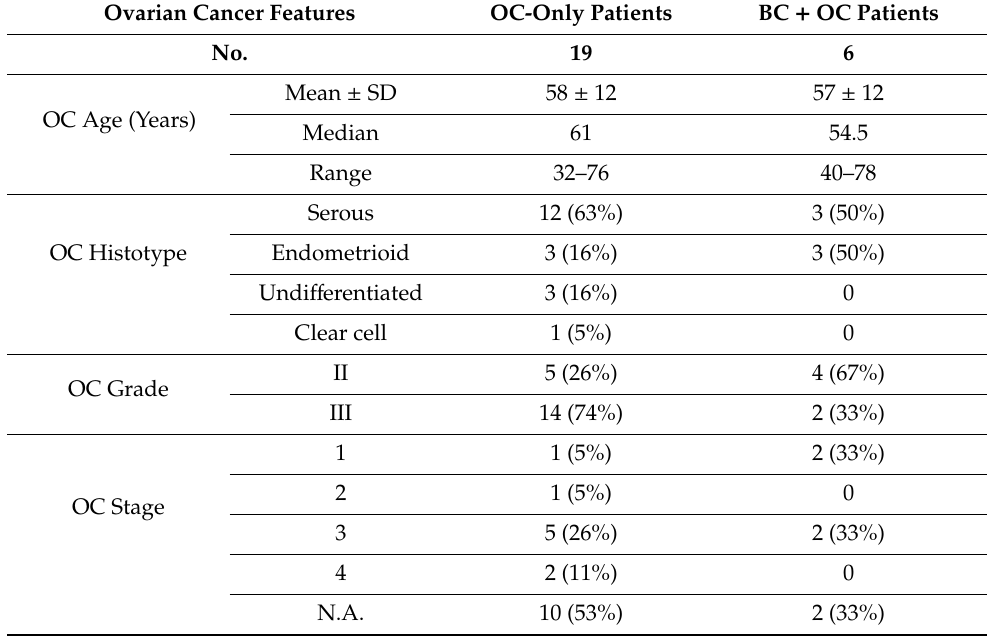
Table 3. Main features of ovarian cancer cases in the study cohort. BC, breast cancer; OC, ovarian cancer; SD, standard deviation; N.A., data not